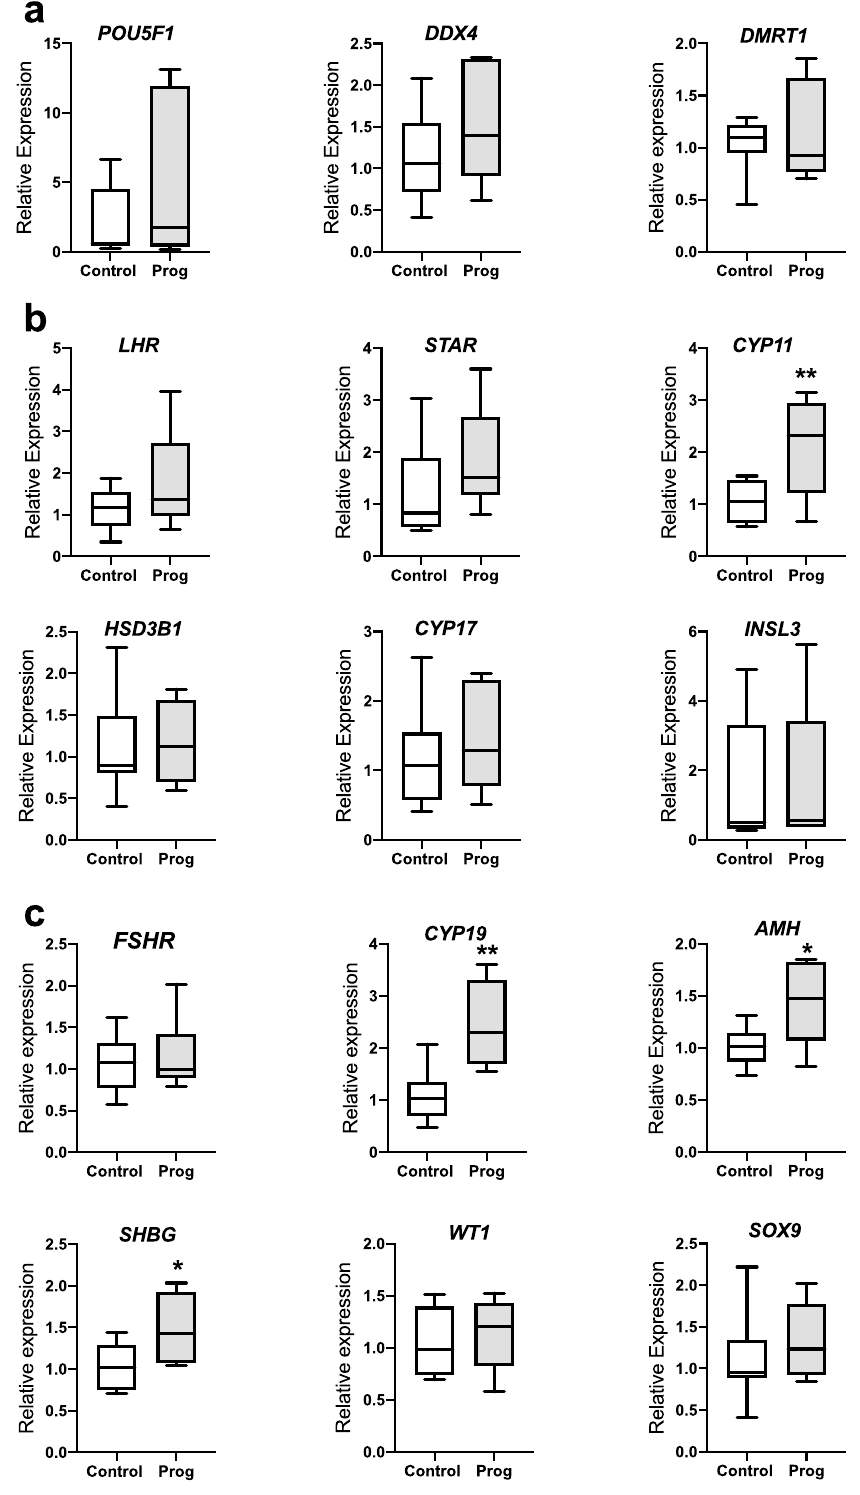
Figure 6. The effect of maternal progesterone administration (Prog) on gene expression in the fetal testis at d75 gestation (Control = 10; Prog = 7). ( a ) There was no difference in POU5F1 , VASA and DMRT1 that are key genes expressed in germ cells ( b ) There was no difference in the expression of LHR , STAR , HSD3B1 , CYP17 and INSL3 that are key genes expressed in Leydig cells. However, expression of CYP11 was increased in Leydig cells after maternal progesterone administration. ( c ) There was no significant change of expression of FSHR , WT1 , SOX9 that are primarily expressed in Sertoli cells. However other key genes ( CYP19 , AMH , SHBG ) expressed in Sertoli cells were increased after maternal progesterone administration. Box plot whiskers are lowest and highest observed values, box is the upper and lower quartile, with median represented by line in box. Unpaired, two-tailed Student’s t test was used for comparing means of two treatment groups with equal variances accepting P < 0.05 as significant (* P < 0.05, ** P <